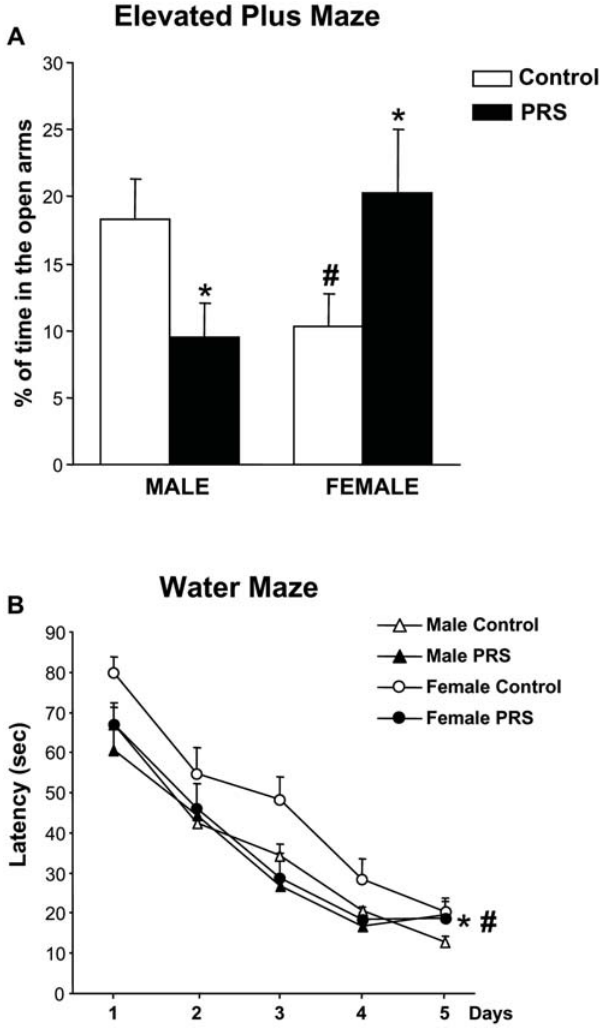
Figure 1. Changes in anxiety-like behavior and spatial learning induced by PRS in male and female rats. The time spent by control and PRS rats in the open arms of the EPM is shown in (A) . No changes in total locomotor activity were detected among groups (data not shown). There was a clear-cut gender effect of PRS in the EPM, ANOVA group 6 sex interaction: F (1,28) =9.92, p , 0.05. Values are expressed as means 6 S.E.M. (n=8 rats per group). ( # ) p , 0.05 control males vs control females; (*) p , 0.05 PRS vs. control animals of each sex (ANOVA + Newman-Keul’s post-hoc test). The latency in finding the hidden platform in the Morris water maze is shown in (B) All groups of animals (control and PRS rats of both genders) were able to learn the task through consecutive trials and days of testing (ANOVA for repeated measure: trials effect F (4-924) =24.06, p , 0.05; days effect: F (4- 924) =127.55, p , 0.05). However, ANOVA also revealed that the performance of control female rats was poorer than that of control male rats ( # p , 0.05: ANOVA sex effect F (1-924) =4.46 and Newman- Keul’s post-hoc test). PRS improved learning in female rats (* p , 0.05: ANOVA group effect F (1-924) =4.46, control females vs all other groups, Newman-Keul’s post-hoc test), but failed to affect learning in male